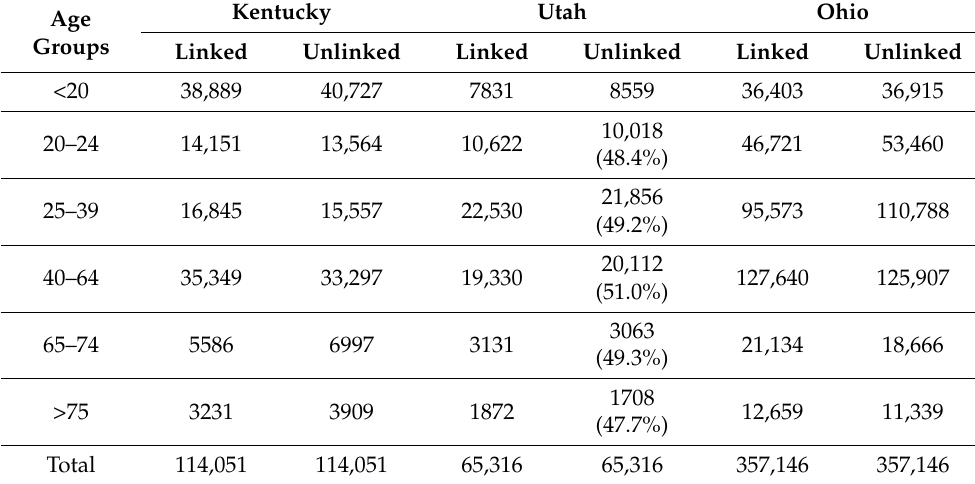
Table 1. Distribution of age